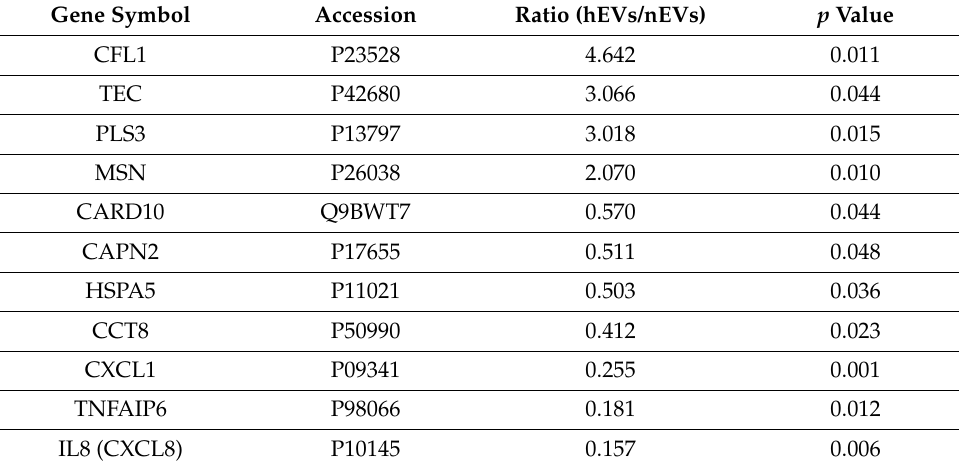
Table 1. Proteomic analysis. Statistically significant hits ( p < 0.05) with a ratio hEVs/nEVs > 1.5 or <0.6. Gene Symbol